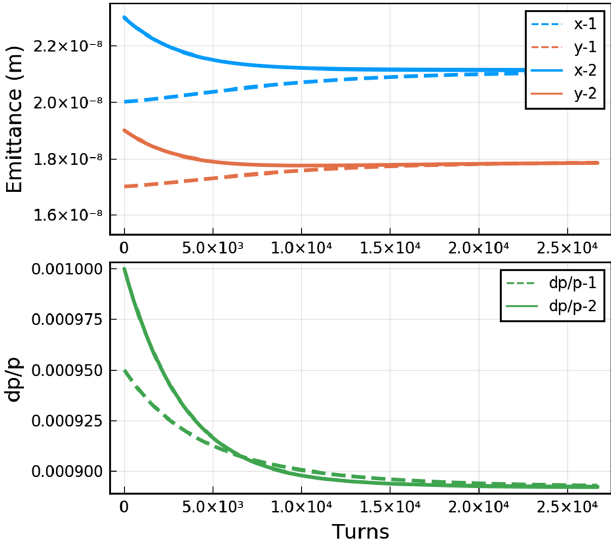
FIG. 5. Evolution of the electron beam parameters in the ring cooler with two sets of arbitrary initial parameters.